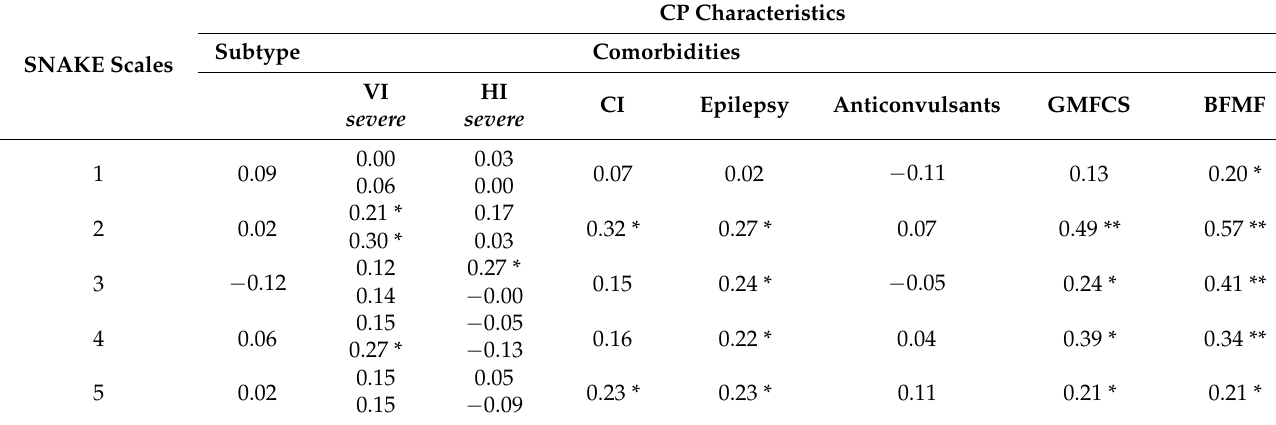
Table 2. Correlation of the SNAKE scale values with the CP subtype, different comorbidities, GMFCS, and BFMF.